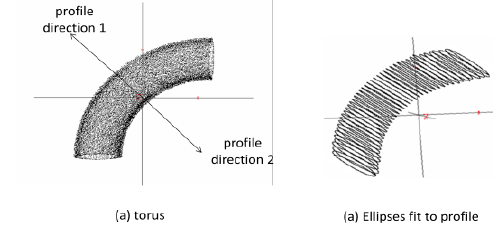
Figure 6.Sample torus (a) with a defined stack direction and (b) detected ellipses from the